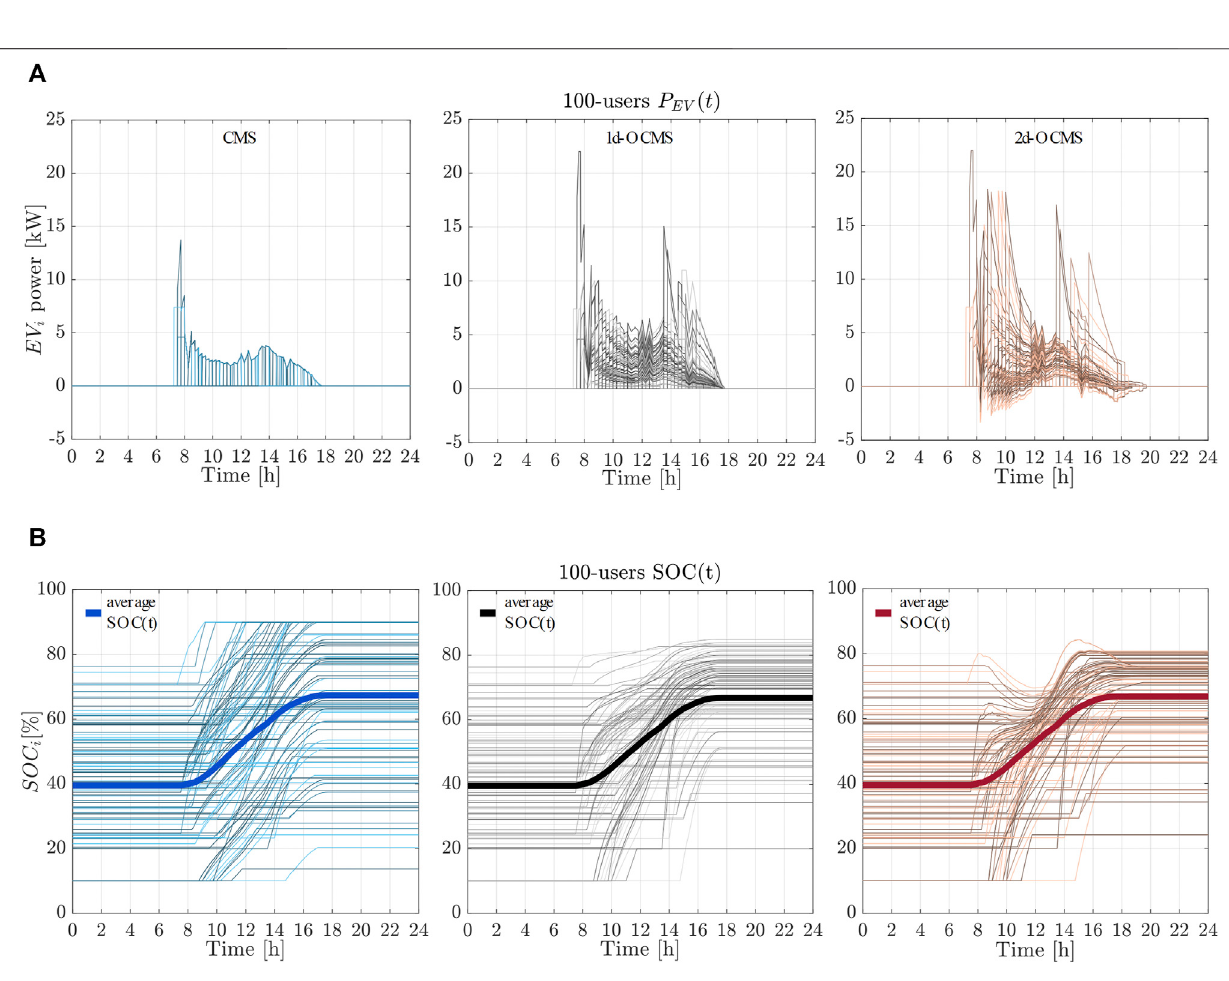
Frontiers in Energy Research |